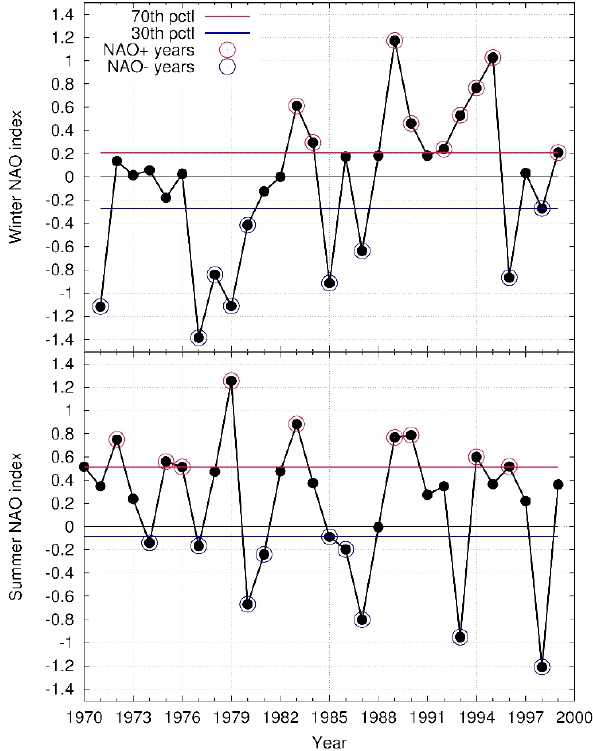
Fig. 2. Winter (top) and summer (bottom) NAO series for the period 1970–1999. The former are DJFM averages (therefore resulting in 29 values) and the latter are JJAS averages (resulting in 30 values). The red (blue) lines denote the 70th (30th) percentile value of each series, highlighting the years/values with a NAO index above (be- low) that percentile, i.e., those selected as NAO + (NAO − ) events for the composites